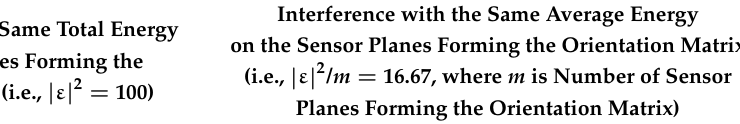
Table 3. The full impact supremum of orientation error θ sup_ fi .